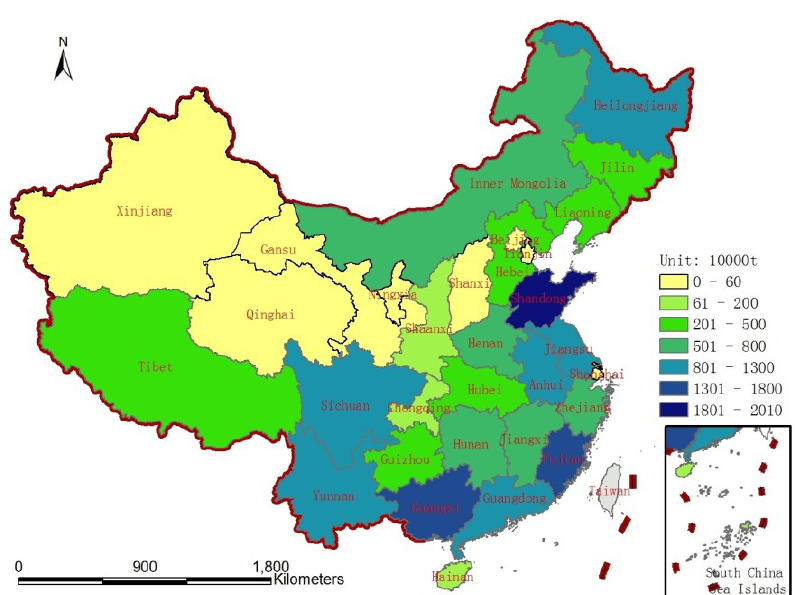
Figure 4. Spatial distribution of forest biomass energy resources across different provinces in China in